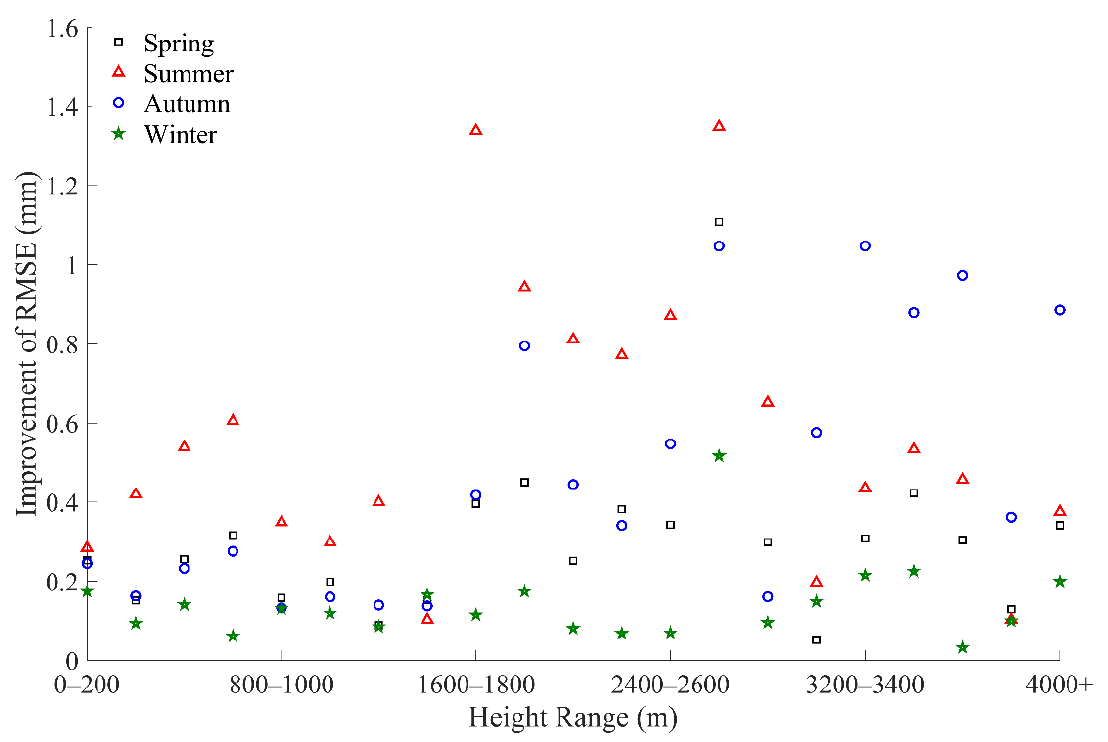
Figure 15. RMSE improvement at different heights.